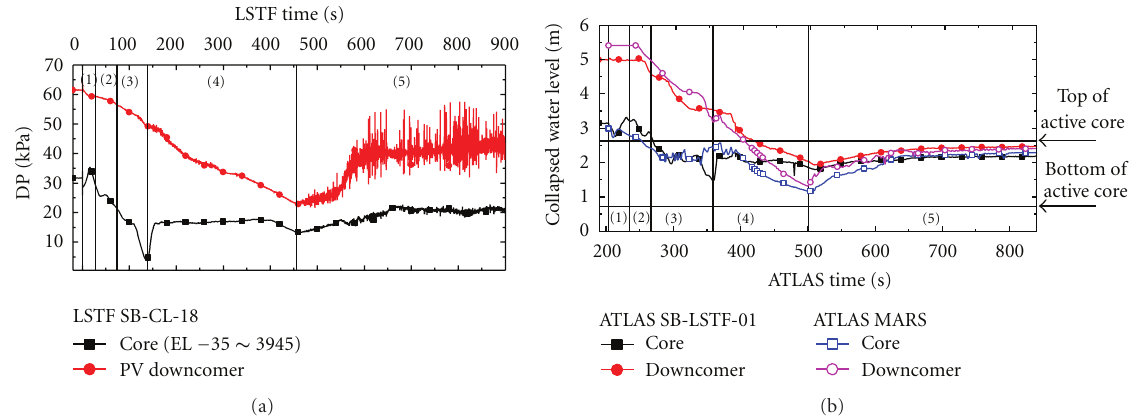
Figure 22: Comparison of collapsed water levels in the LSTF counterpart test.